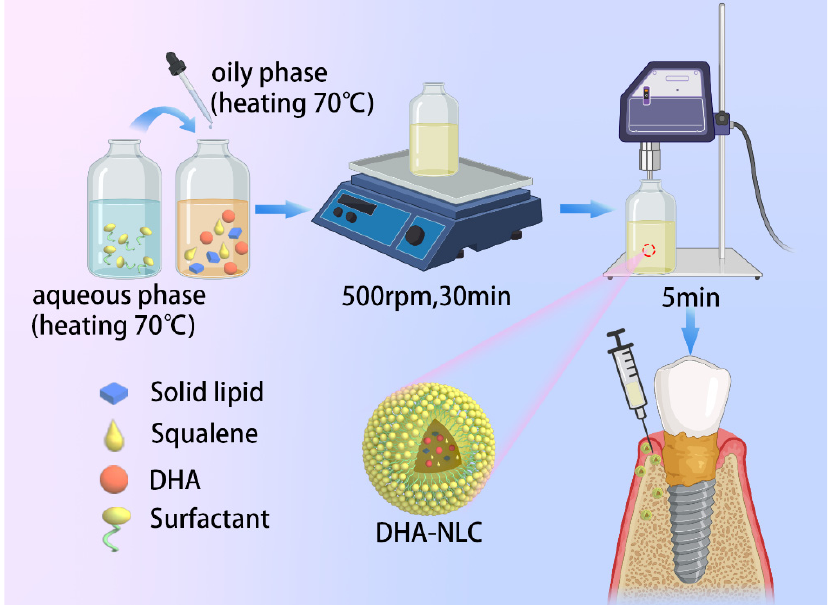
Figure 1. Schematic diagram of the preparation and application of the DHA-NLC. A DHA-loaded NLC was fabricated using heating and ultrasonication methods. A surfactant constituted the peripheral spherical shell, while DHA and squalene were encapsulated inside. DHA-loaded NLC exerted anti-inflammatory effects in a rat model of peri-implantitis by attenuating the pro-inflammatory factor levels and preventing alveolar bone resorption. NLC, nanostructured lipid carrier. DHA, docosahexaenoic acid.